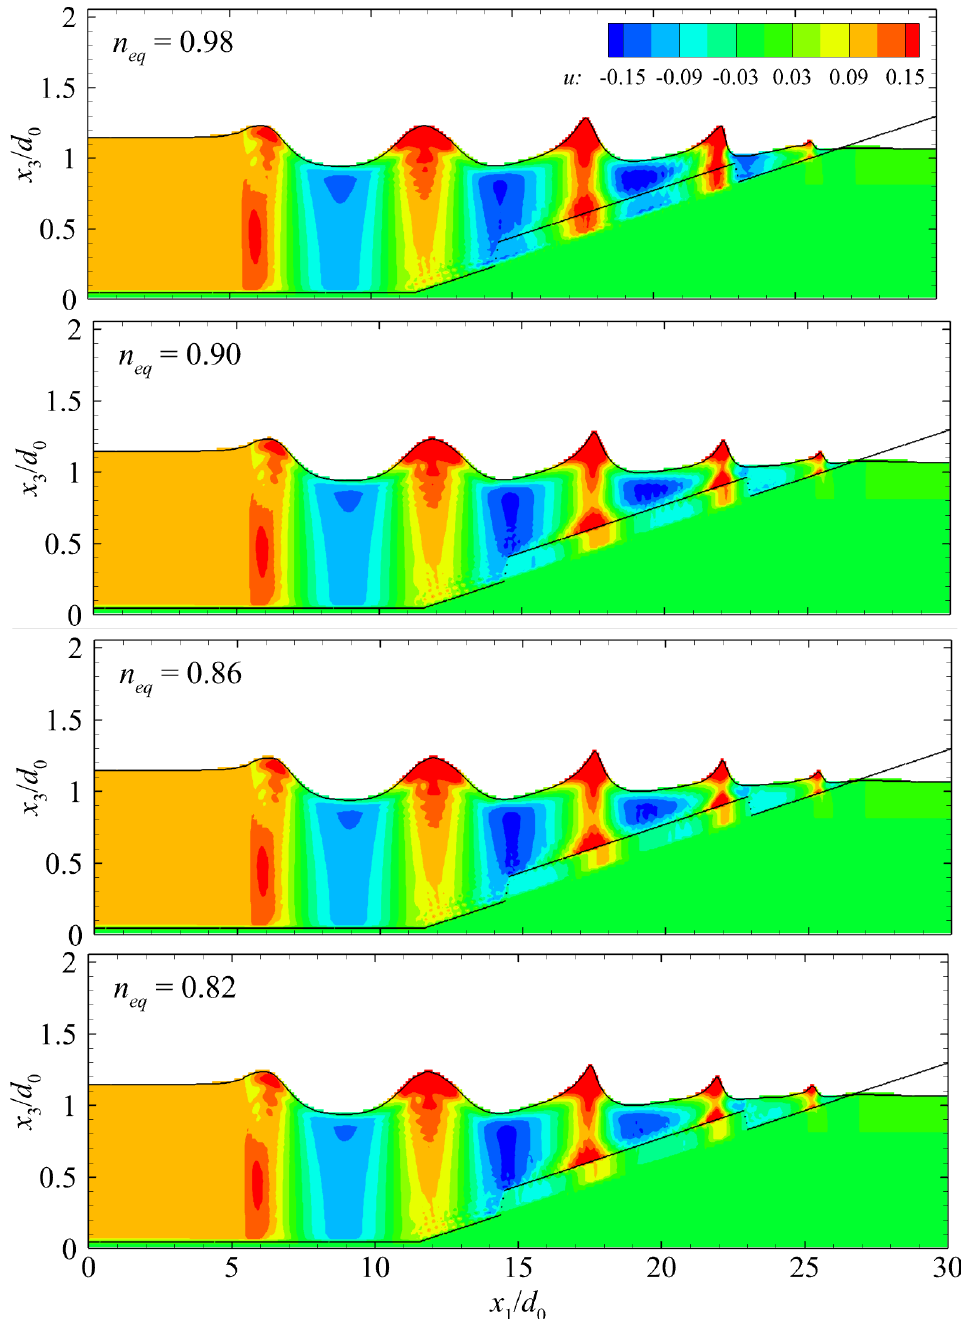
Figure 6. Instantaneous 2DV snapshots of streamwise velocity induced by waves propagating over CV fields with L CV = 1.66 L and different n eq (Cases 2–5). Note that the coordinate axes are in scale x 1 / x 3 = 0.2 for clarity of the exposition.